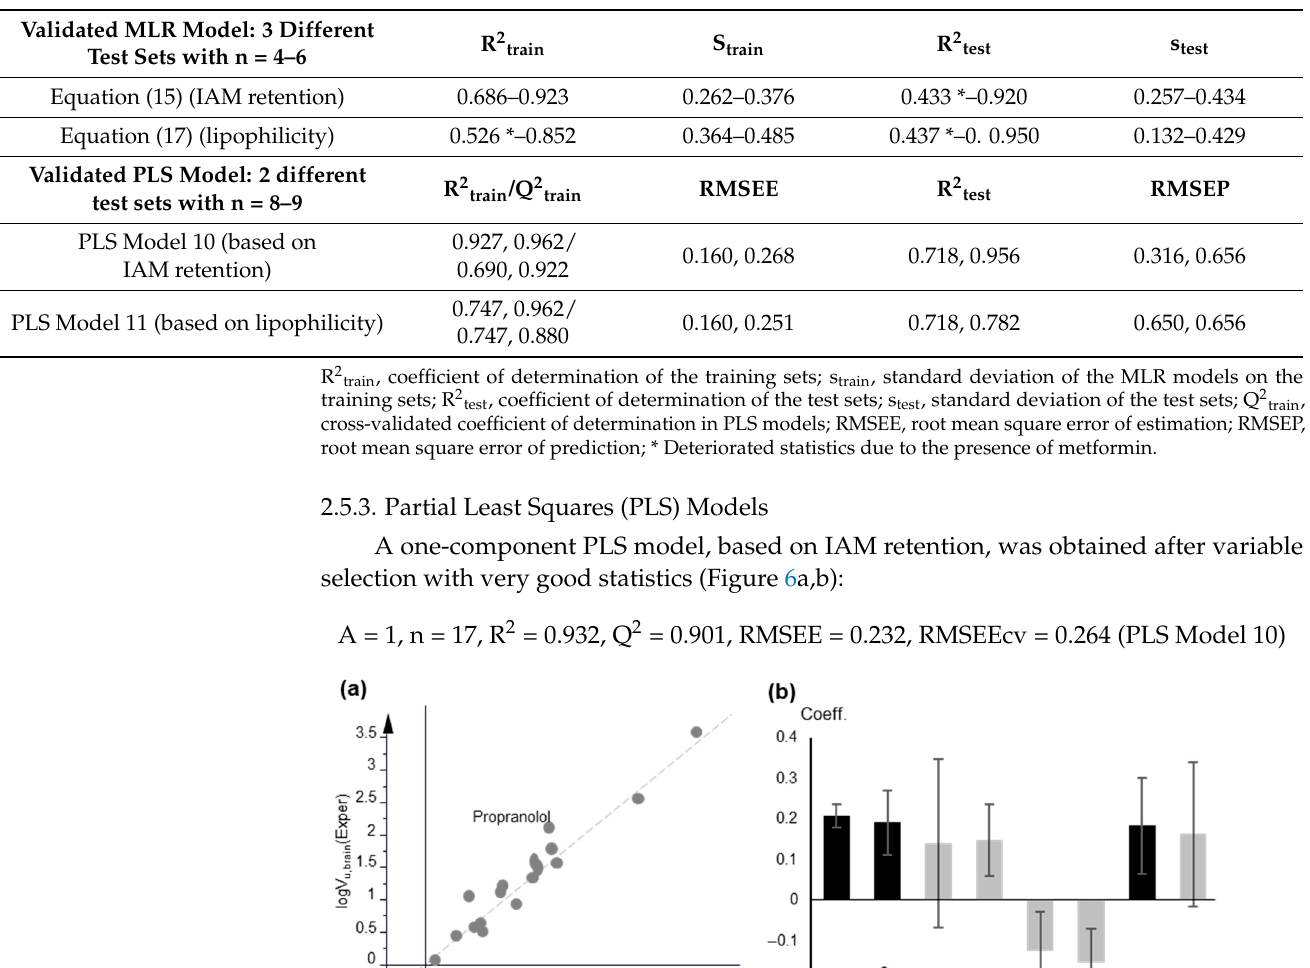
Table 4. Ranges of statistical values for the training and external test sets for models validated by logV u,brain .